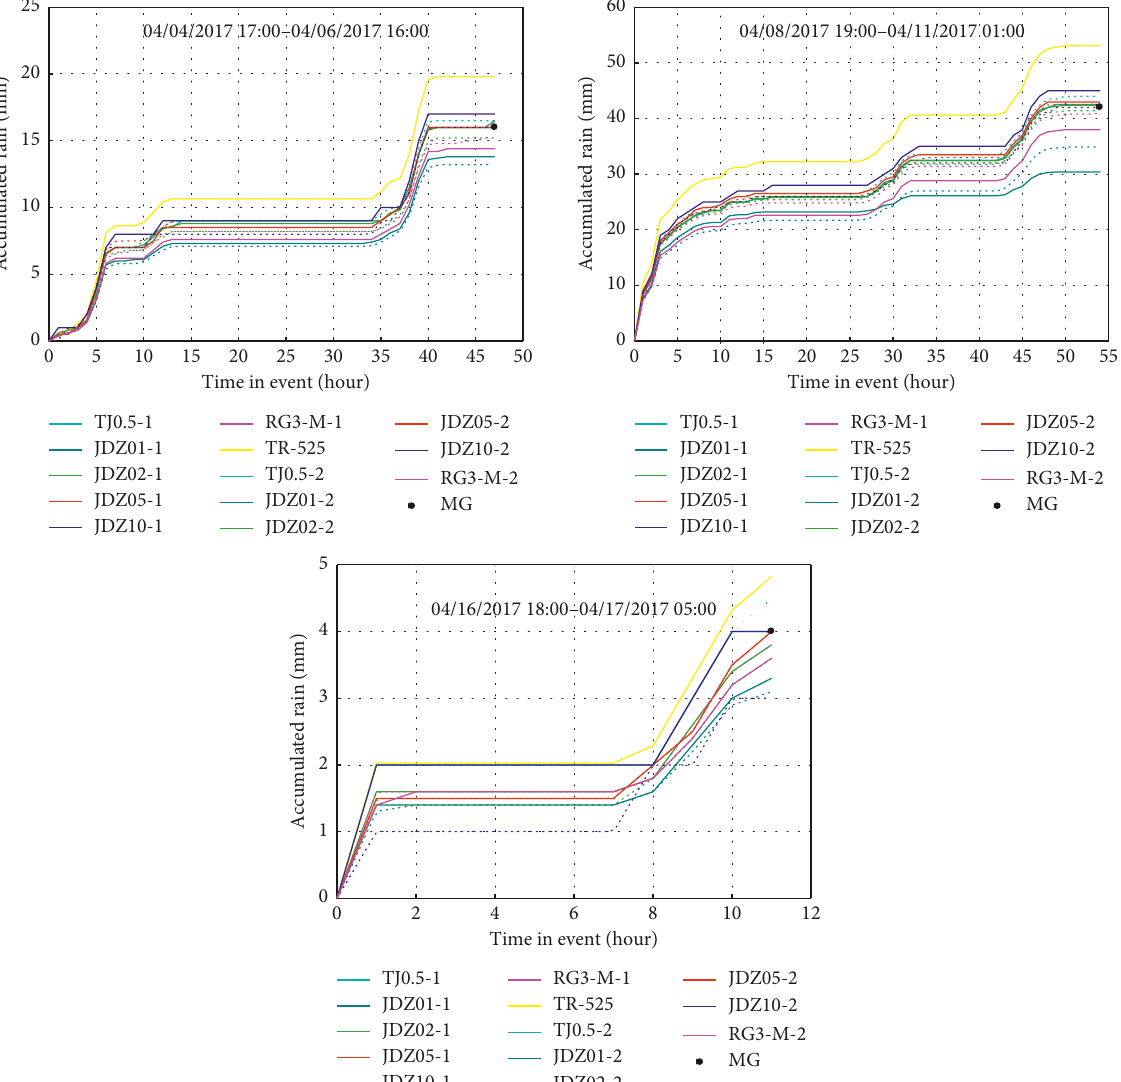
Figure 5: Cumulative rainfall measured by 13 rain gauges for three storms on 4 April 2017, 8 April 2017, and 16 April, 2017 recorded at the Hydrometeorological Observation Field, respectively (dot indicates the total depth of rainfall recorded by the manual